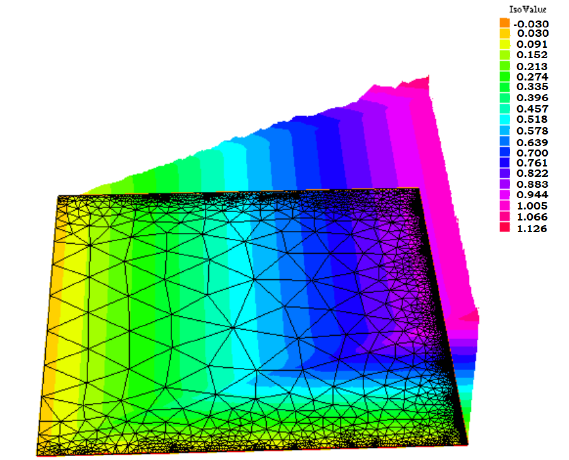
Figure 21. A 3D plot of the computed solution for example 4.